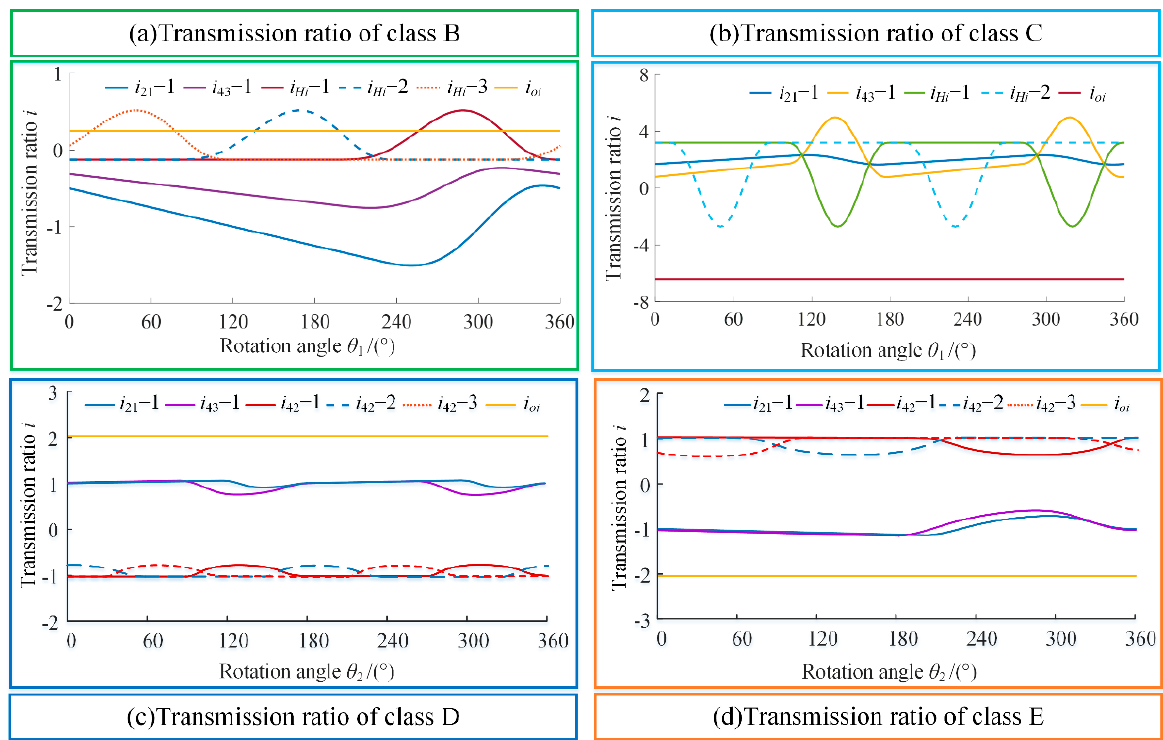
Figure 8. Transmission ratio variation law of class B~E. Figure 7 is the variation law of the transmission ratio of class A. θ e = Φ − θ p is